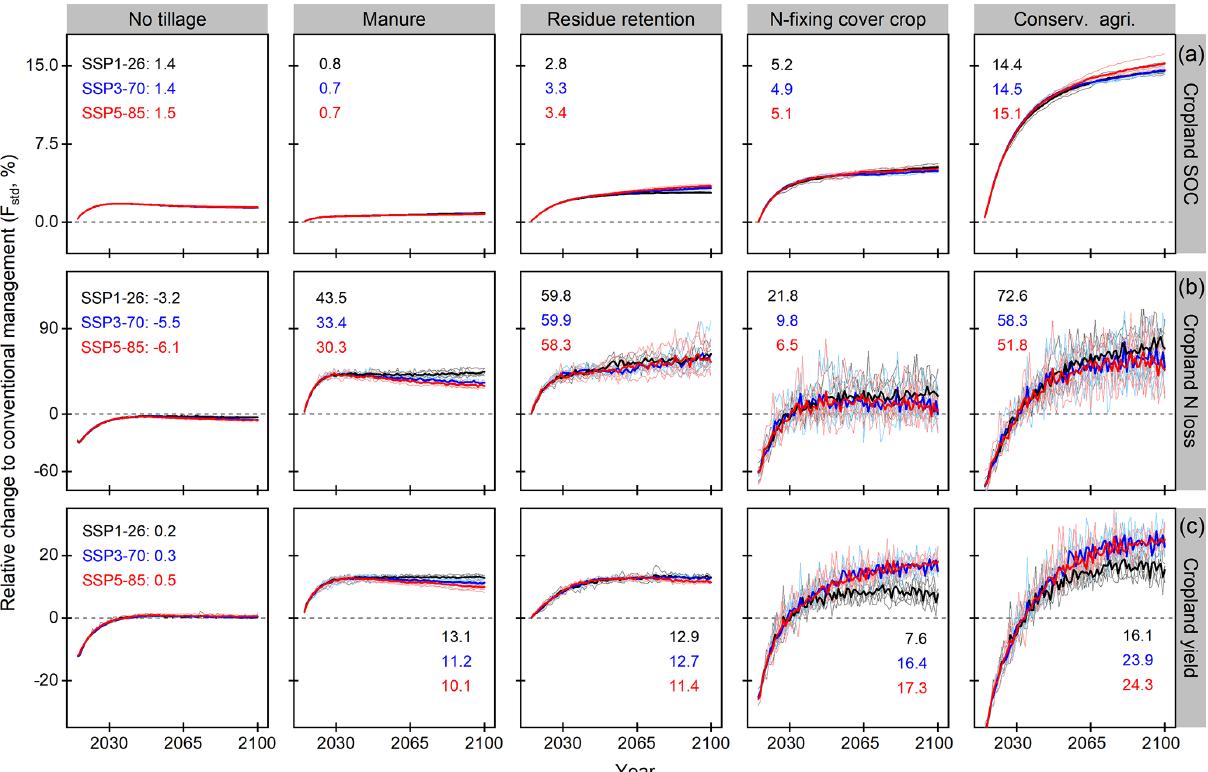
Figure 6. The simulated response (%) of cropland SOC (a) , N loss (b) , and yield (c) to alternative management techniques, relative to the conventional management ( F std ). The dark black, blue, and red lines denote the mean of simulations using five GCMs (see Table 1) for SSP1-26, 3-70, and 5-85 scenarios, respectively. Lines in lighter colours represent the simulation driven by individual GCMs. Numbers in plots indicate the averaged results between 2091 and